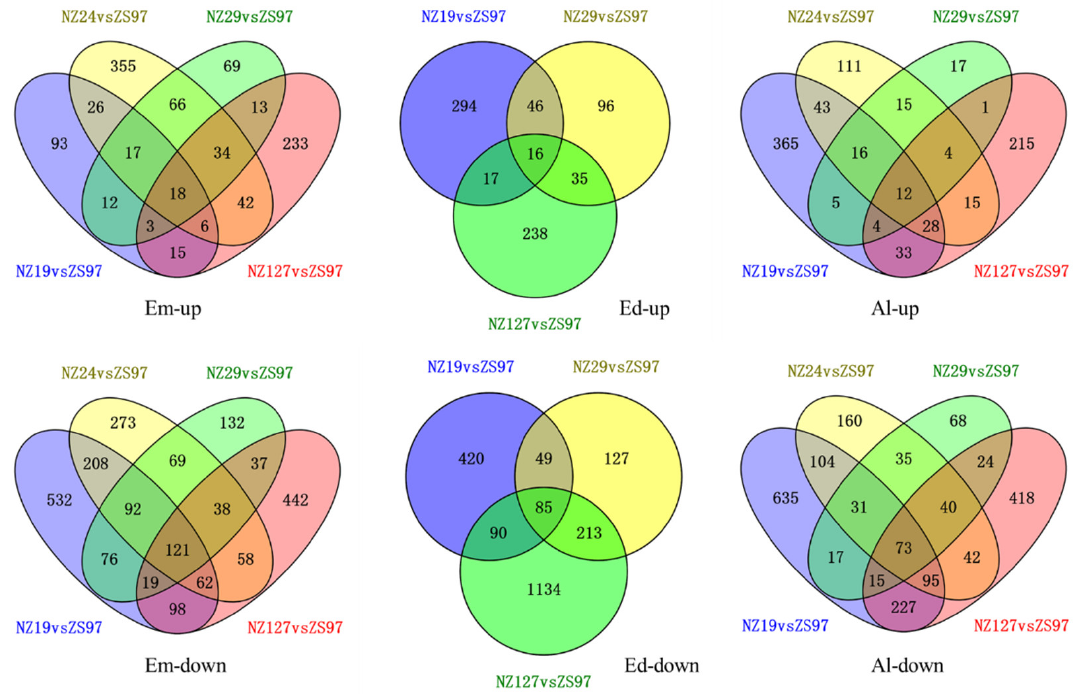
Figure 7. Venn diagram of differential expressed genes between 4 selected NILs (NZ19, NZ24, NZ29, NZ127) and ZS97. Em, Ed, Al, and Hu represent embryo, endosperm, aleurone layer, and hull.